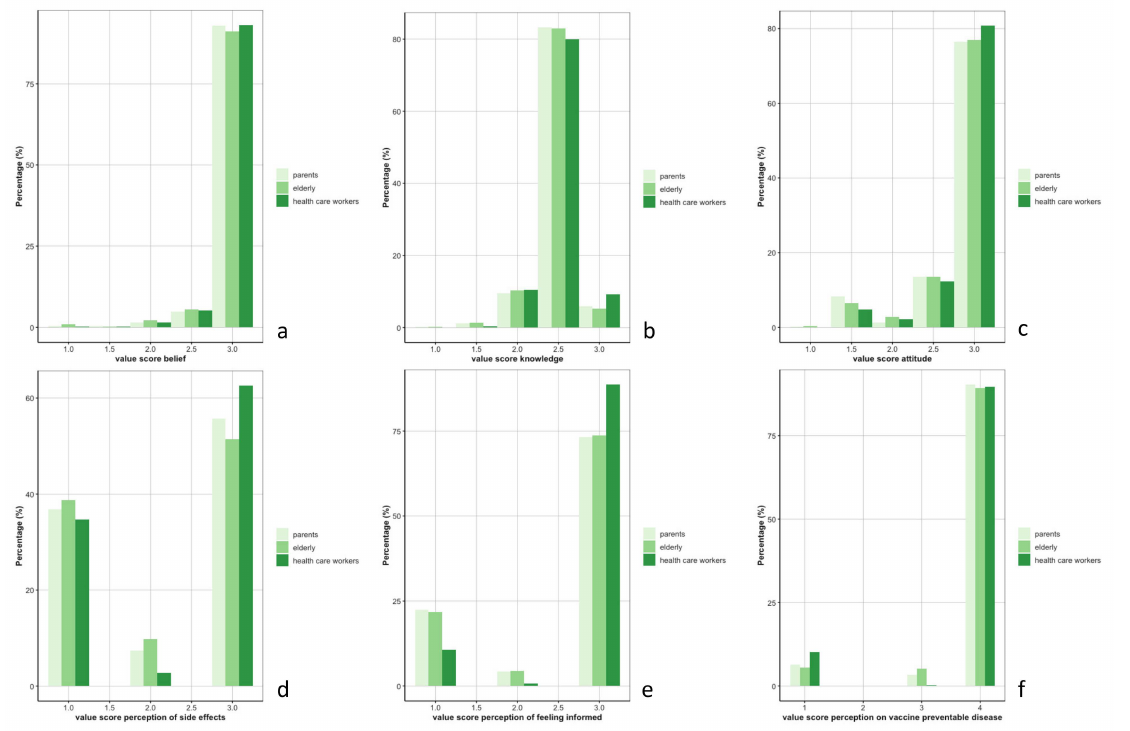
Figure 2. Distribution of the scores for the 6 concepts—( a ): belief, ( b ): knowledge, ( c ):